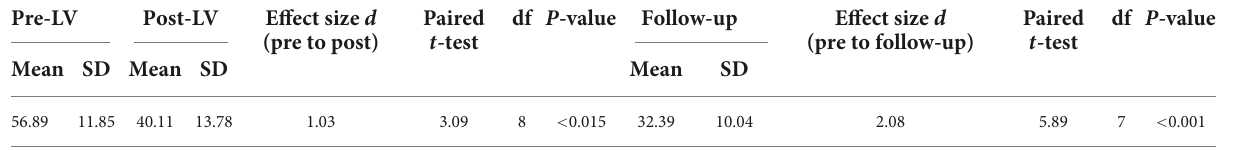
TABLE 2 Mean differences in Inventory Depression and Anxiety Symptoms-General Depression scale (IDAS-GD). Pre-LV Post-LV Effect size d Paired df P -value Follow-up Effect size d t -test (pre to post) (pre to